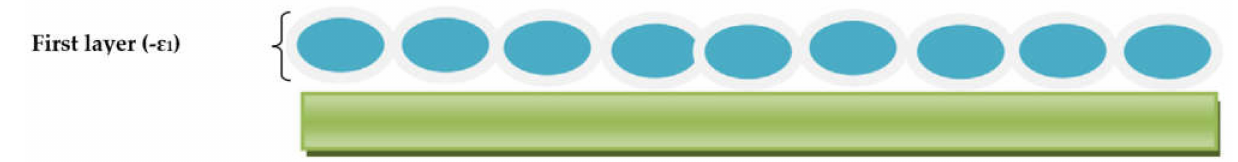
Figure 1. Schematic illustration of the distribution of the molecules adsorbed on a solid according to the monolayer model with a single energy.